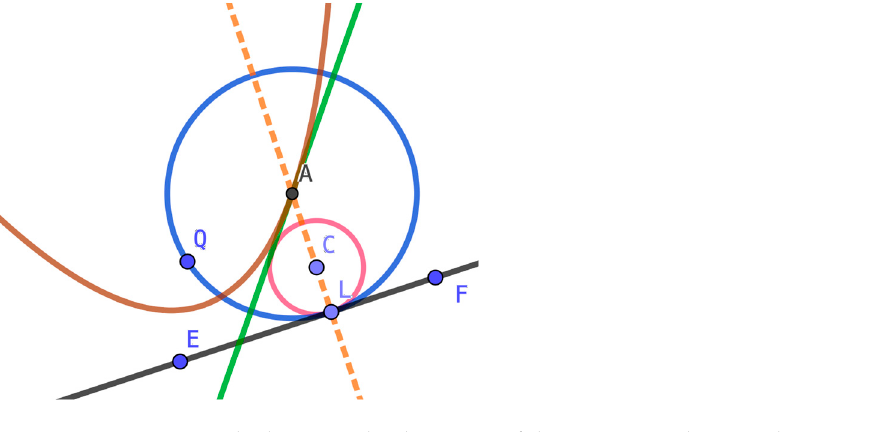
Figure 5. Any point on the locus can be the center of the tangent circle to EF that passes through point Q.